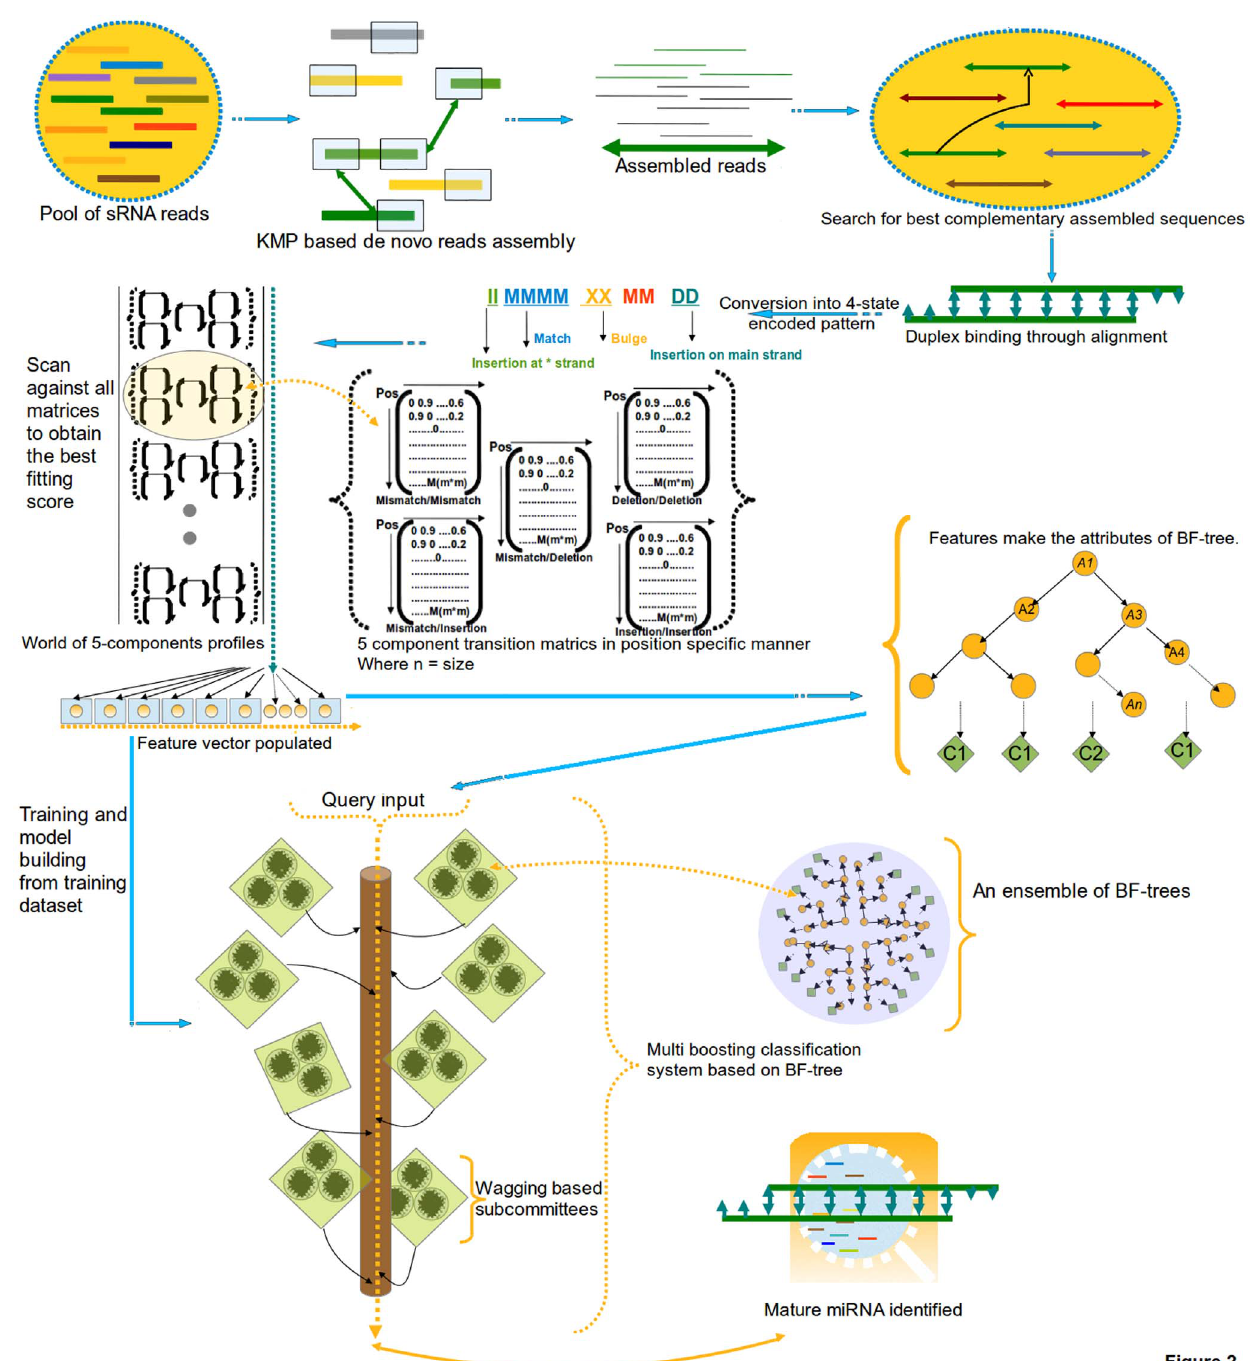
Figure 1. Work flow of miReader algorithm.